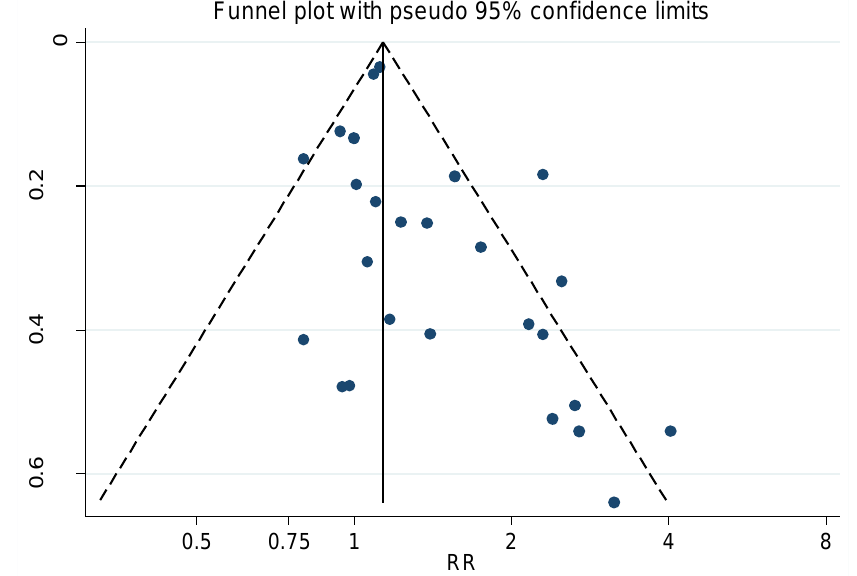
Figure 3. Funnel plot for the relative risk (RR) estimates from all studies of the association between amyotrophic lateral sclerosis (ALS) and Alzheimer’s disease together and occupational exposure to electromagnetic fields (EMFs) as shown in Figure 1. Begg’s test, p = 0.023. Estimates from the studies on ALS and Alzheimer’s disease were grouped into estimates with narrow CIs (high precision estimates) and estimates with wider CIs (low precision estimates) and a Metacum based on an ordering by precision is shown in Figure 4. The weighted RR for these eight studies with high precision estimates [30,31,33,35–37,40,43] was 1.14 (95% CI 1.01–1.27) compared with RR 1.68 (95% CI 1.33–2.13) for the twelve studies with low precision estimates [22,28– 30,32,34,35,38–42].